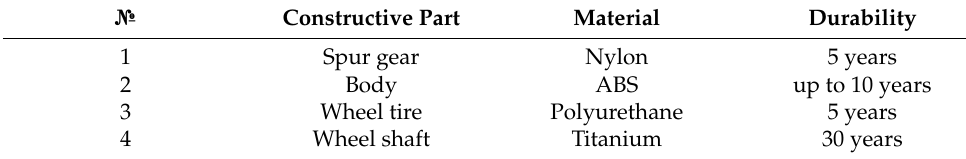
Table 4. Materials used in the design of the